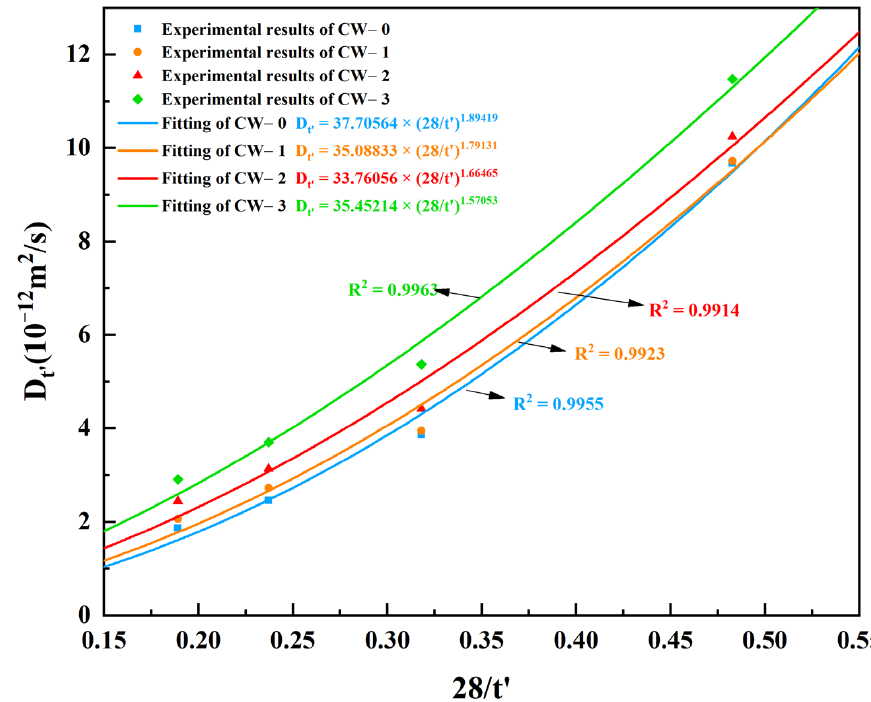
Figure 8. Relationships between the apparent chloride diffusion coefficient and exposure time.